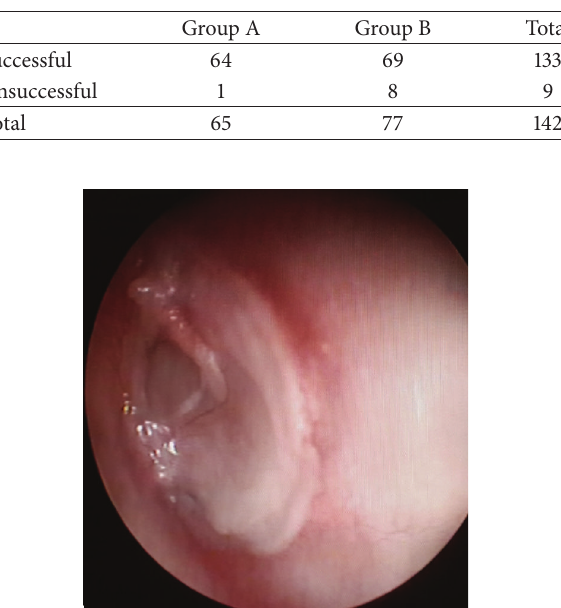
Figure 2: Postoperative picture at 6 months after modified cartilage shield